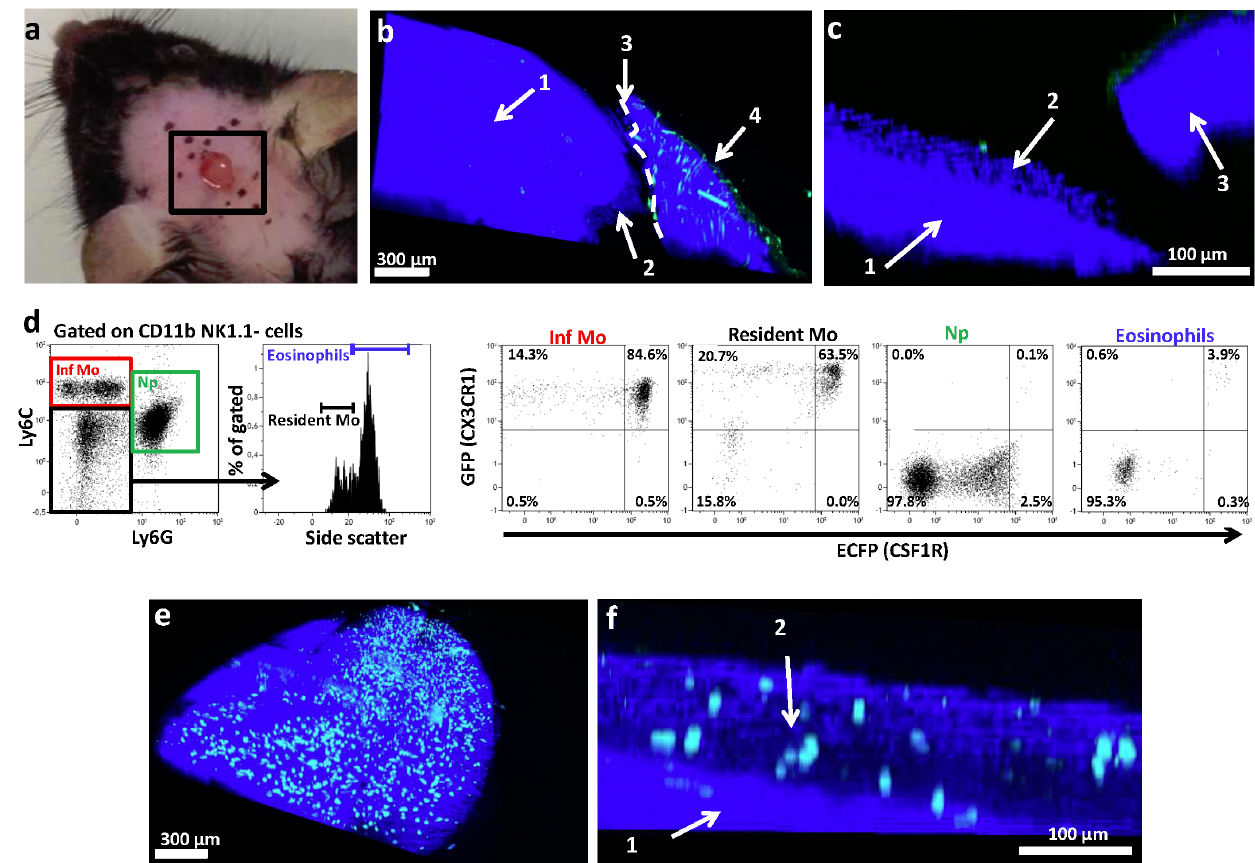
Figure 1. MP wound infiltration was localized to the deep skin layer. ( a ) Representative picture of skin wound excision. Pictures represent ( b ) front and ( c ) transversal two-photon laser scanning microscopy (TPLSM) 3D reconstruction of the wound site of a C57Bl6 mouse, 3 h after injury. The second harmonic generation (SHG) signal is in blue, and autofluorescent hairs in green. ( d ) Representative dot plot showing GFP and ECFP expression on distinct blood myeloid subsets from MacBlue 6 CX3CR1 gfp/ + mice. ( e ) Front and ( f ) transversal TPLSM 3D reconstruction of the wound site in MacBlue 6 CX3CR1 gfp/ + mouse, 4 h post-wounding. The SHG signal is in blue, the ECFP signal in cyan, and the GFP signal in green. Legends represent 1 : Skull; 2 : Deep skin layers; 3 : Wound edge; 4 : Skin. Inf Mo: Inflammatory monocytes; Np: neutrophils; Resident Mo: resident